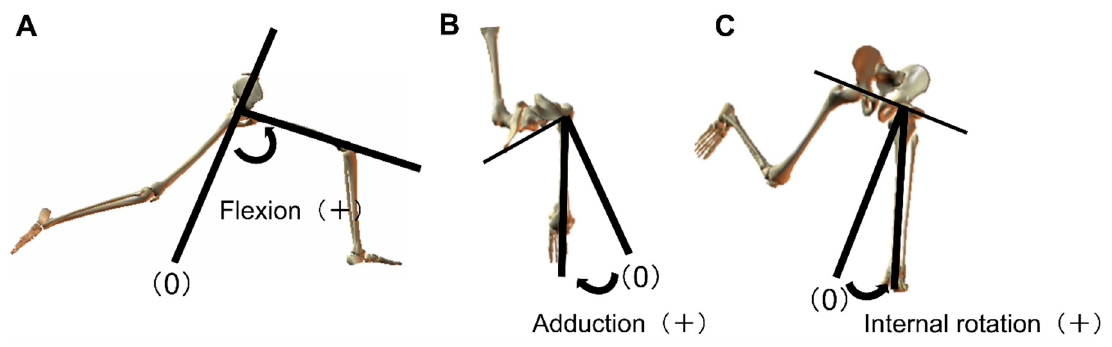
Figure 3. Hip joint angle. ( A ): flexion, ( B ): adduction, ( C ): internal rotation.